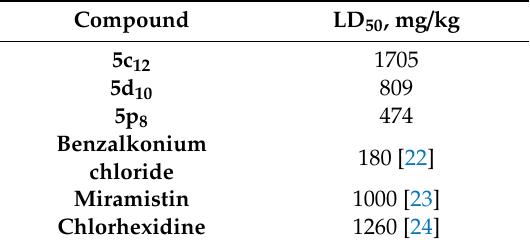
Table 5. Toxicology data obtained on oral administration of compounds 5c 12 , 5d 10 , and 5p 8 to CD-1 mice.